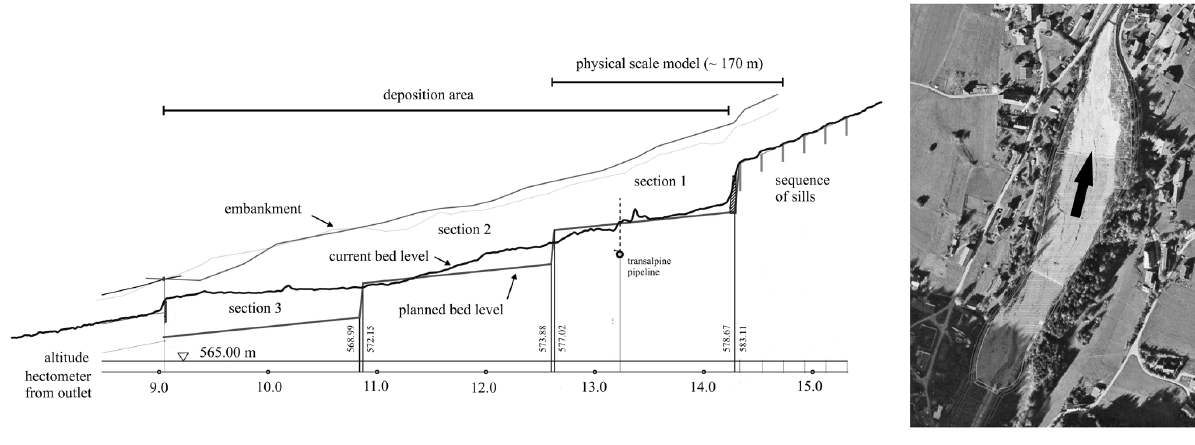
Fig. 2. General concept (left) and plan view of the bedload retention area (right; source: